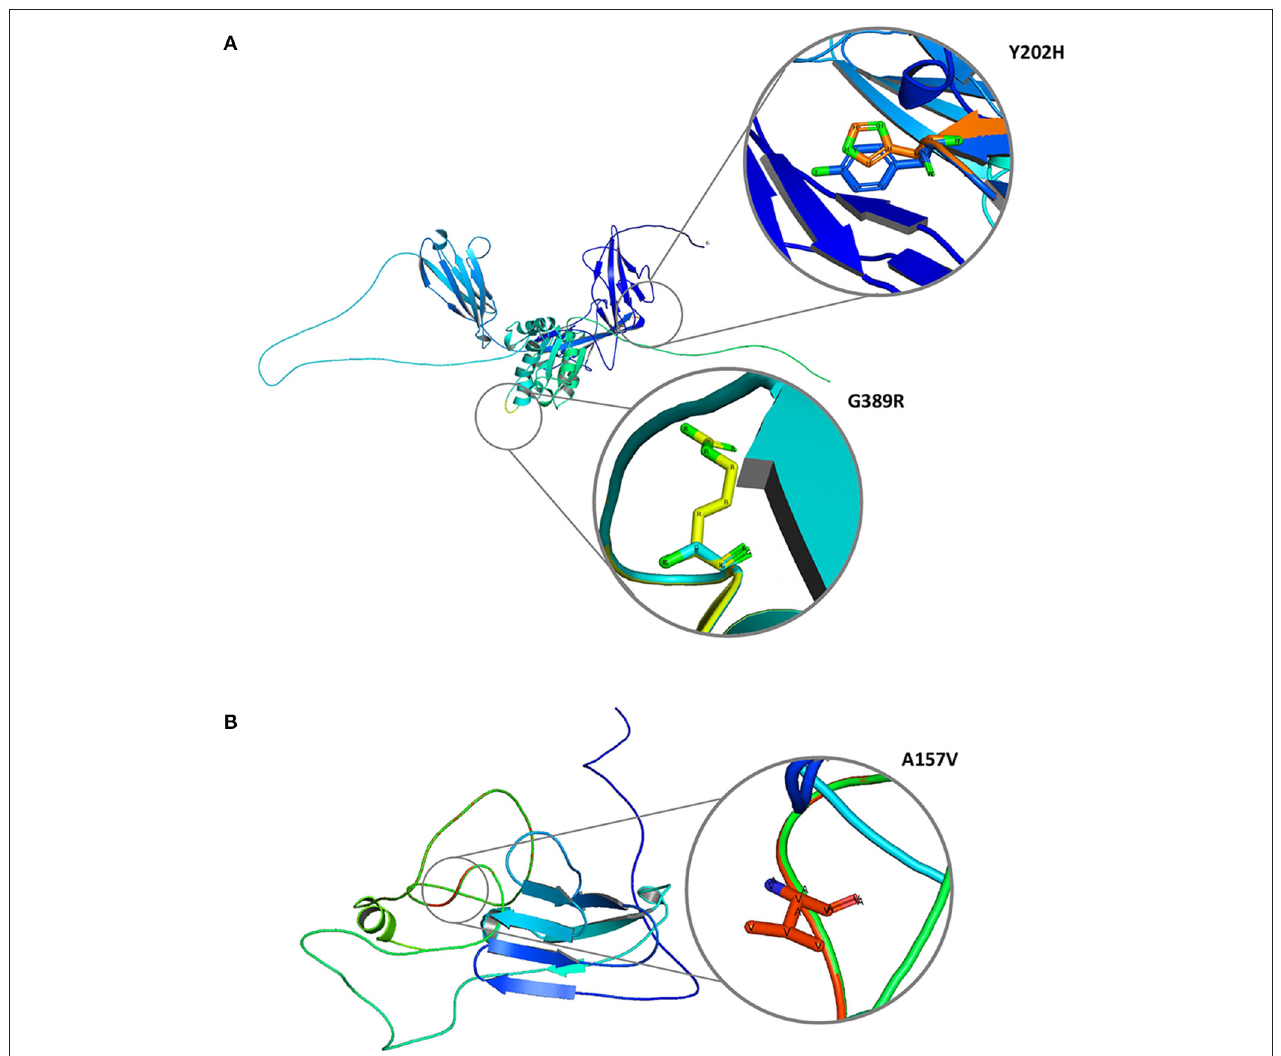
FIGURE 7 | Molecular graphical visualization of normal and mutated 3D protein structure models using Pymol software. (A) IL1R1 protein variants Y202H and G389R. (B) CD3E protein variant A157V.